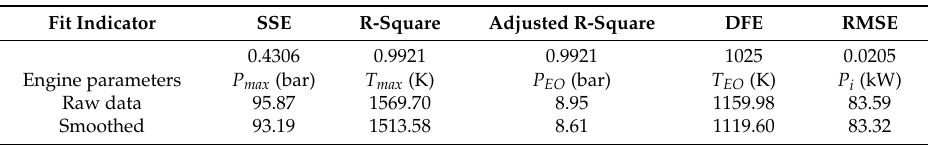
Table 3. The goodness of fit of the pressure